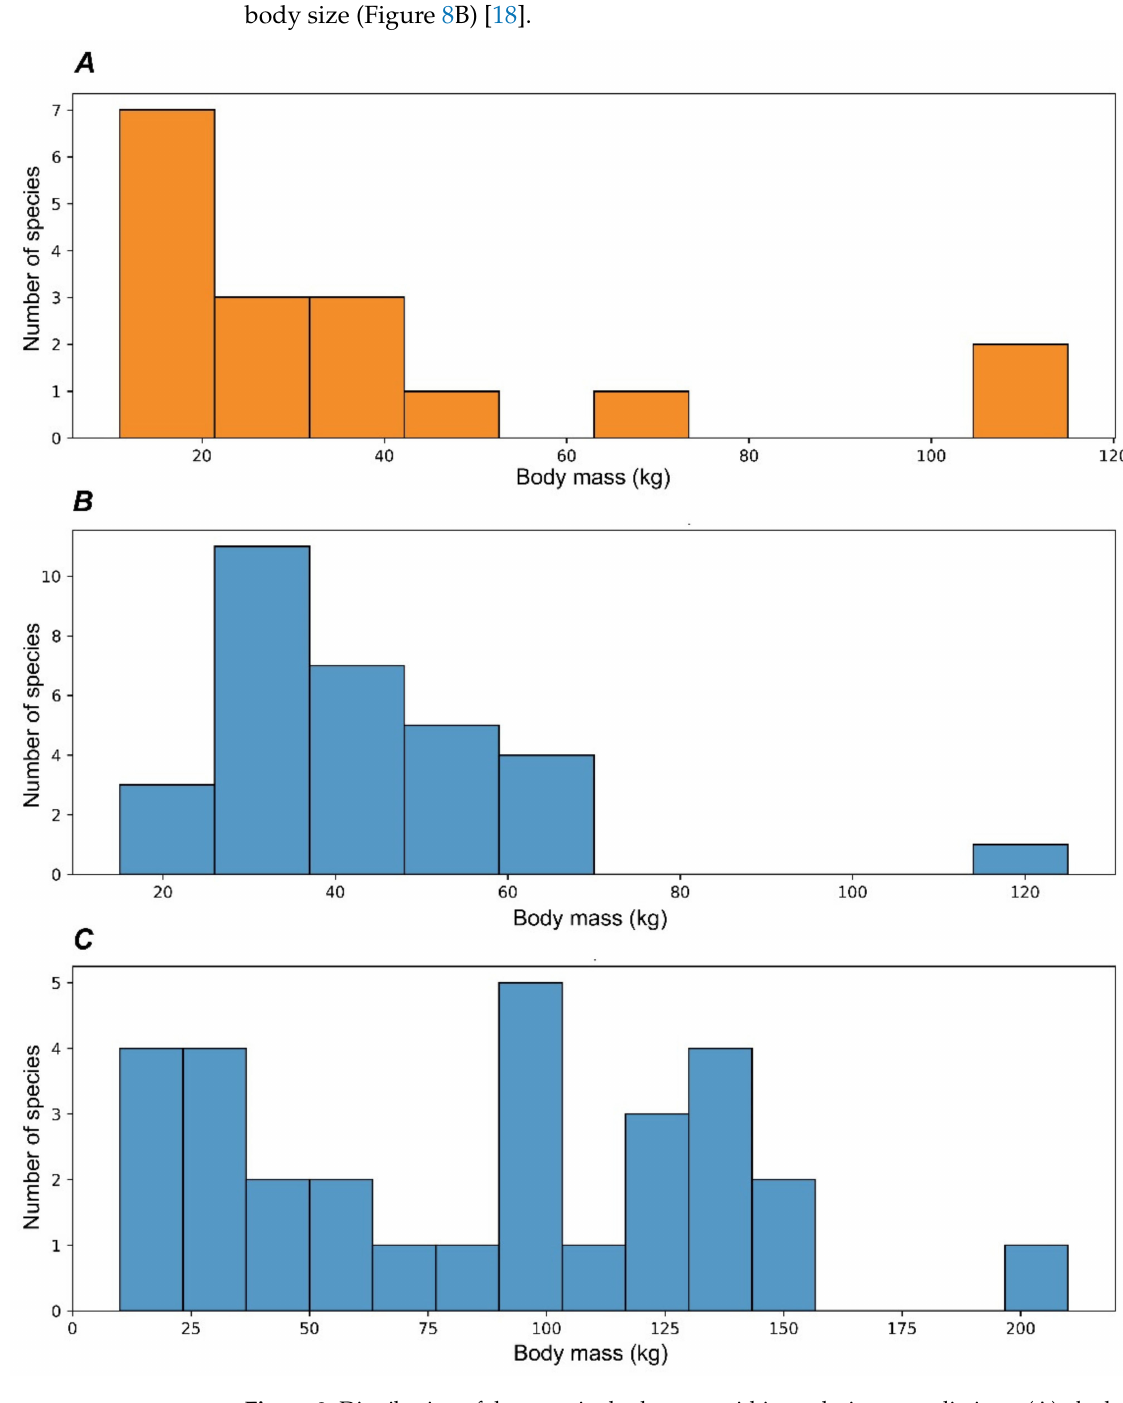
Figure 8. Distribution of deer species body mass within evolutionary radiations: ( A ), the late Miocene radiation of the subfamily Cervinae in Eurasia; ( B ), the late Miocene radiation of the subfamily Capreolinae in Eurasia; ( C ), the Pleistocene radiation of the subfamily Capreolinae in South